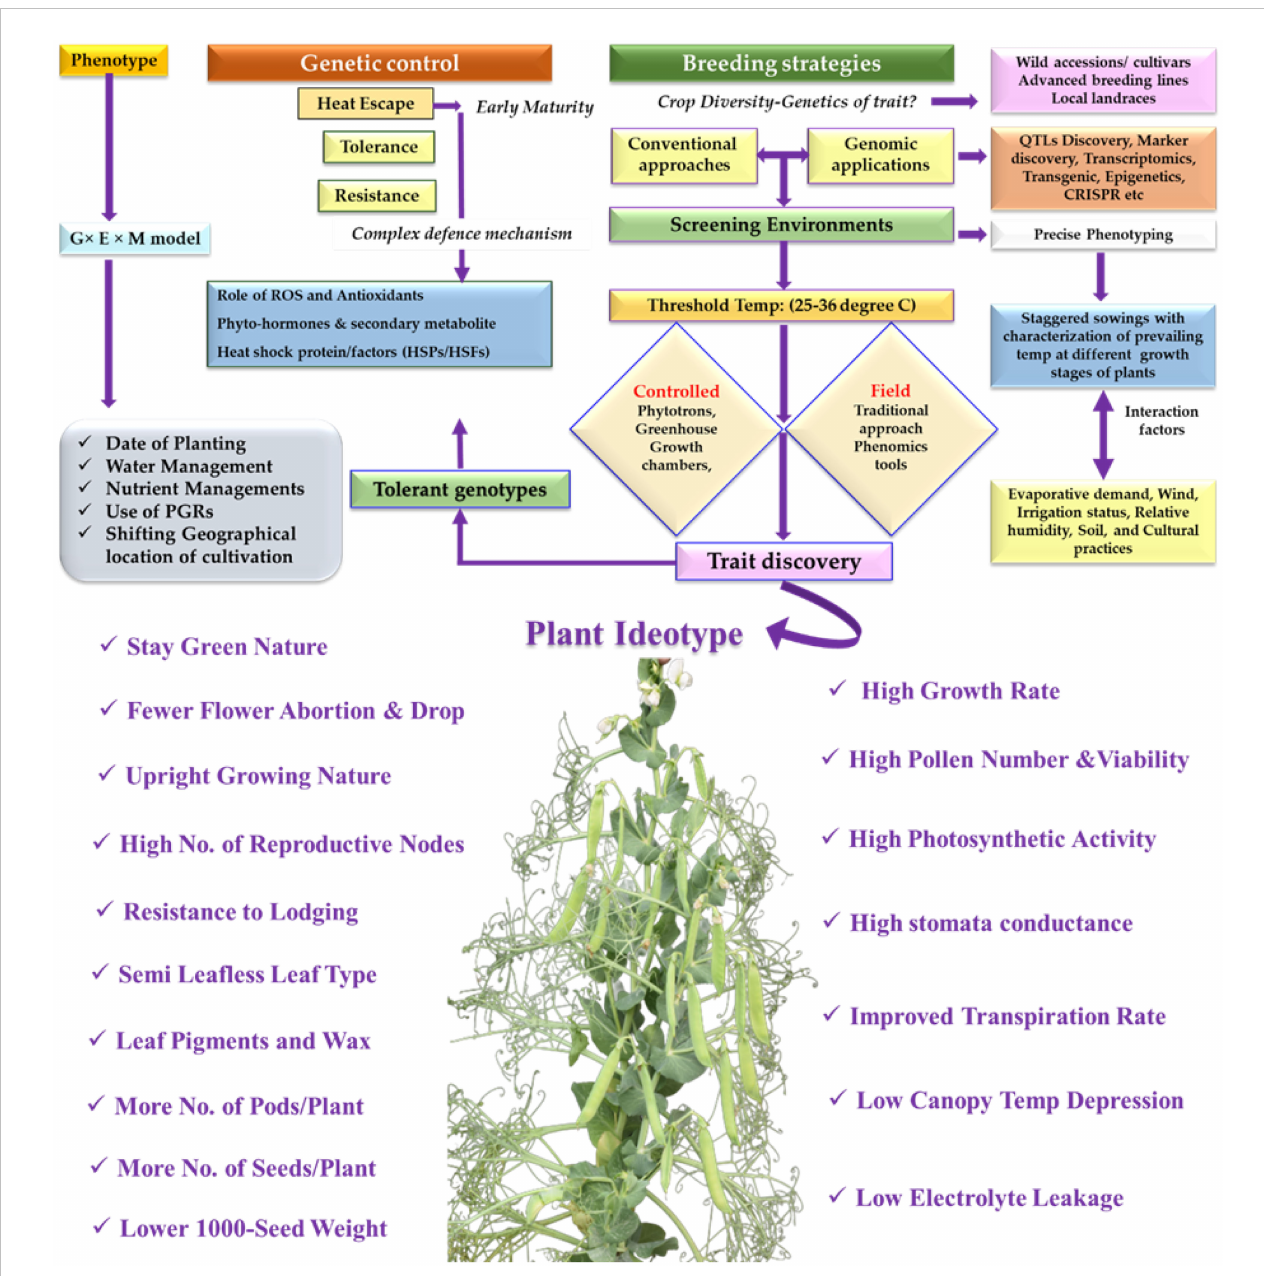
FIGURE 3 Breeding for heat stress tolerance in Pisum; The phenotypic performance of cultivars under heat stress is determined by Genotype × Environment × Management Model. Ideotype breeding for HS includes combination of Agro-morphological and physiological